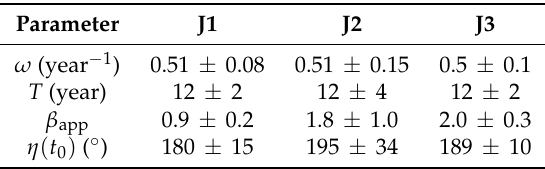
Table 1. The kinematic properties of model